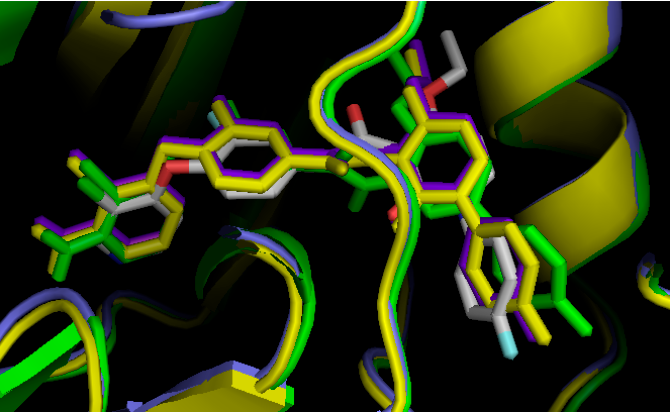
Figure 3. In silico screening of the DFG-Asp out homology models, using BMS777607. Tyro-3 in purple ; Axl in green; Mer in yellow ; and BMS777607 from the crystal structure of c-Met (PDB ID:3F82), in white. In each case, the color of BMS777607 is the same as that of the docking target.